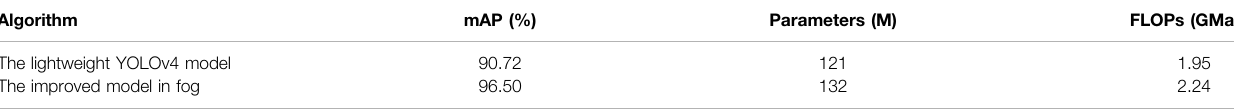
TABLE 5 | The performance comparison between the lightweight YOLOv4 model and the improved model in fog. Algorithm